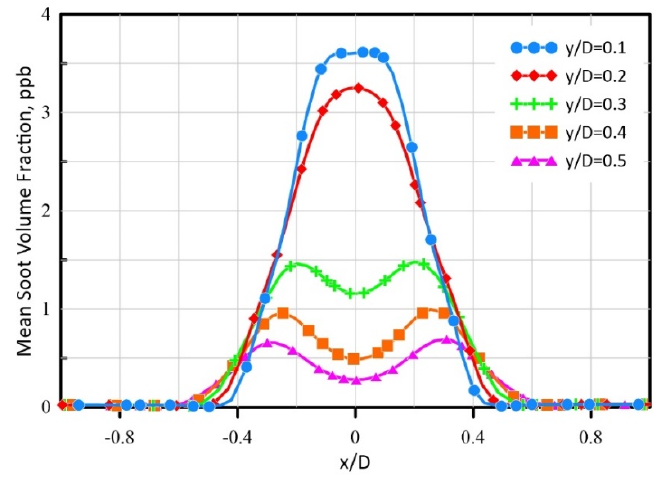
24 of 26 Figure A1. Mean temperature profiles depending on the mesh number of nodes, K. Figure A2. Mean axial velocity profiles for three types of meshes. The soot concentration effect was estimated using the Moss–Brooks–Hall model for case 1 (1 atm and 293 K). This model shows a maximum volume concentration of soot of the order of 1–5 ppb, which is close to the values obtained in [36]. The distribution of the